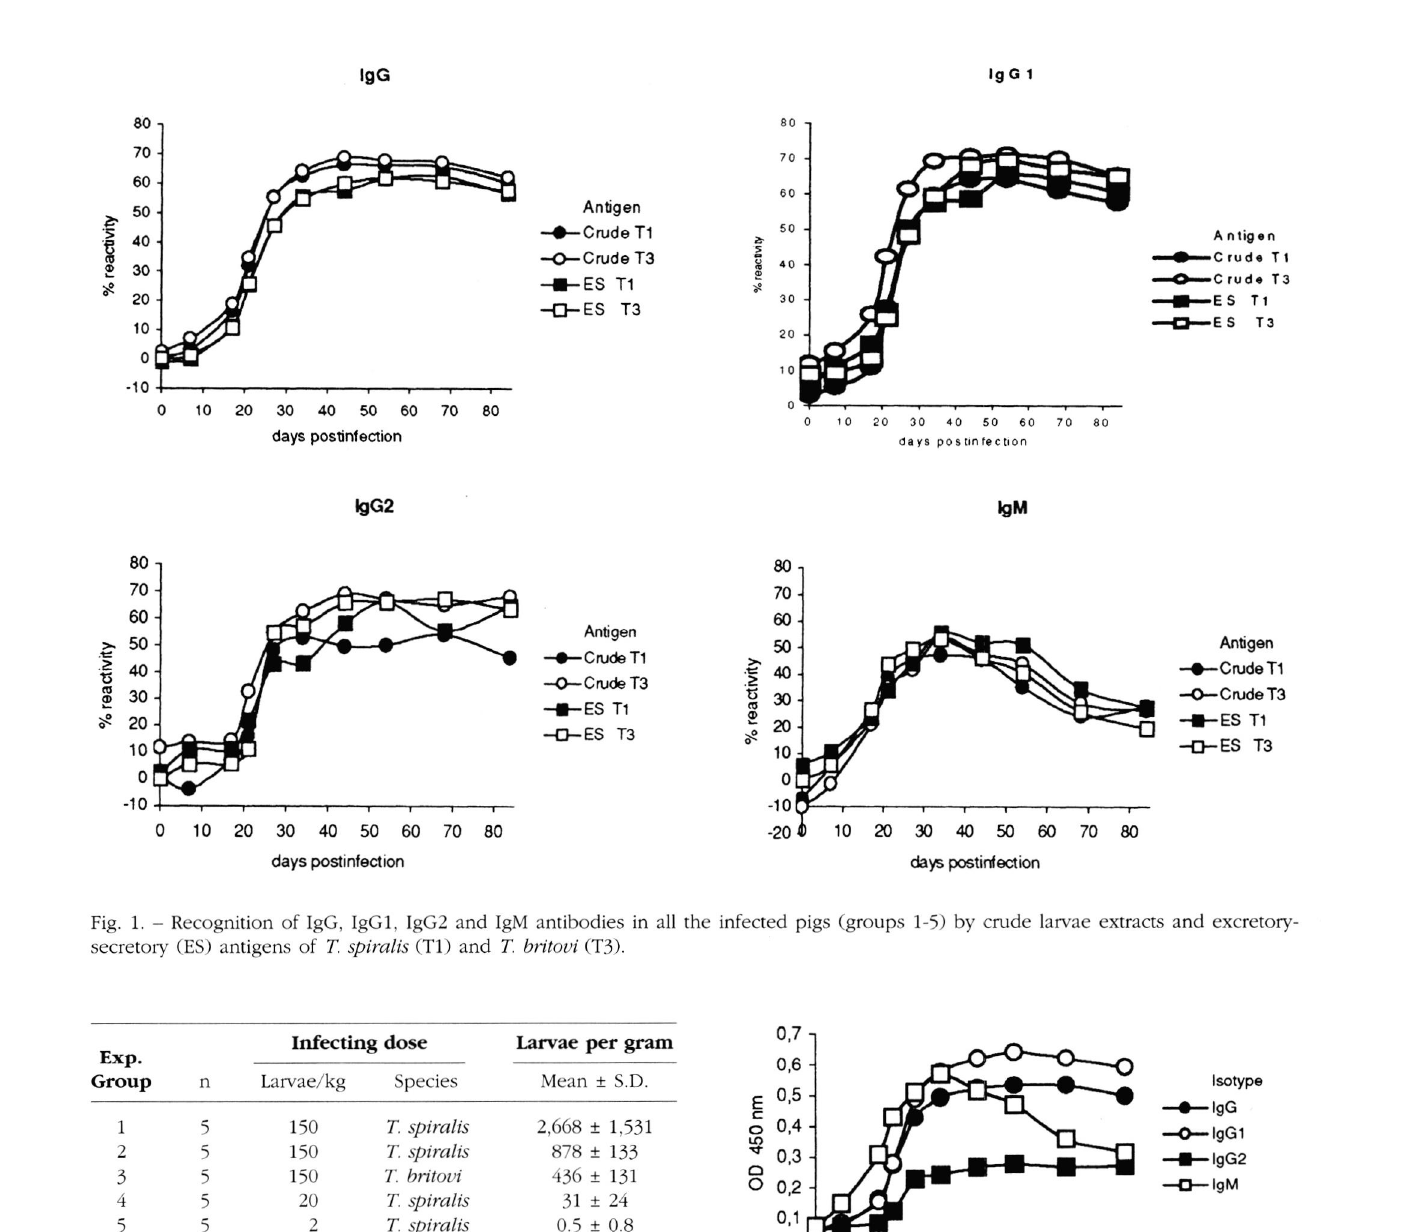
Table II. - Experimental design of experimental groups and level of infection obtained by artificial digestion.